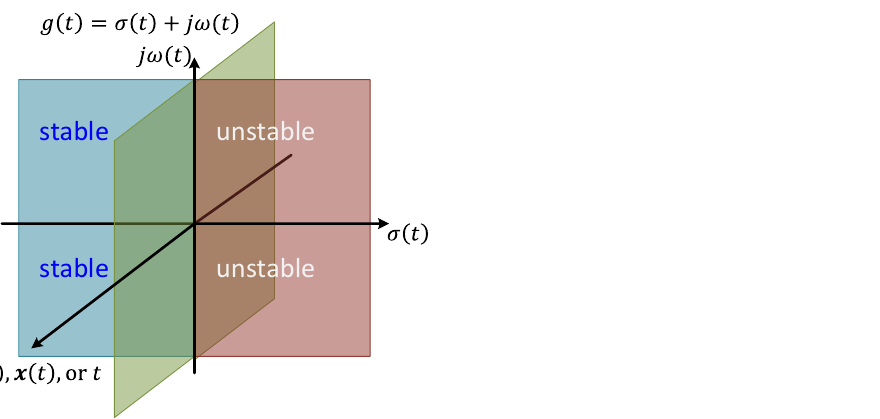
Figure 4. Having the stability region, a three-dimensional g -plane consists of a real part 𝜎(𝑡) , imag- inary part 𝑗𝜔(𝑡) , and time-dependent part. The time-dependent part can be time 𝑡 , error 𝑒(𝑡) , or state variable 𝒙(𝑡) .